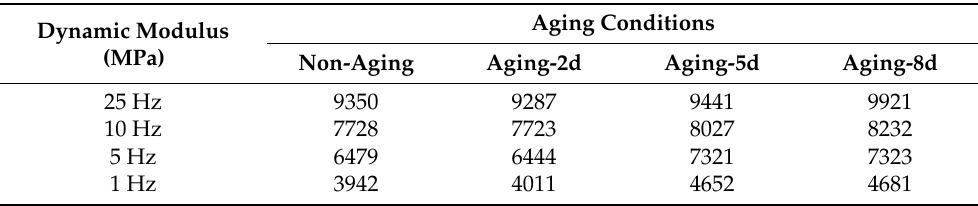
Table 7. Results of dynamic modulus of the asphalt mixture.